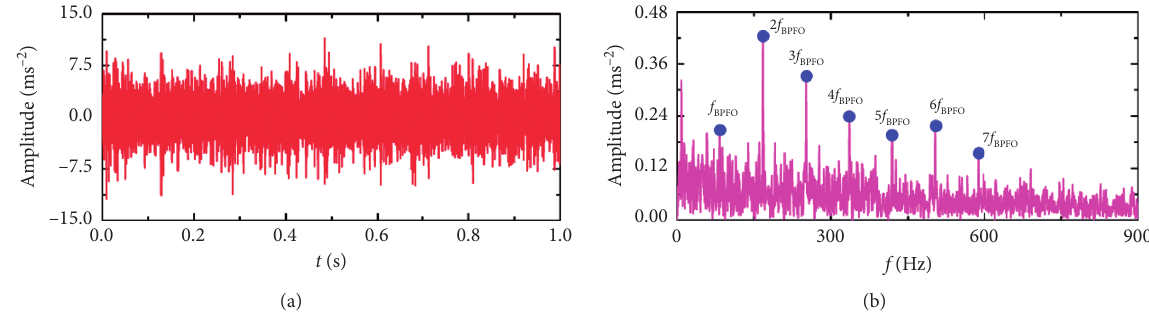
Figure 15: Results obtained by ALIF-OMPK: (a) extracted signal and (b) Hilbert envelope spectrum of signal in (a).